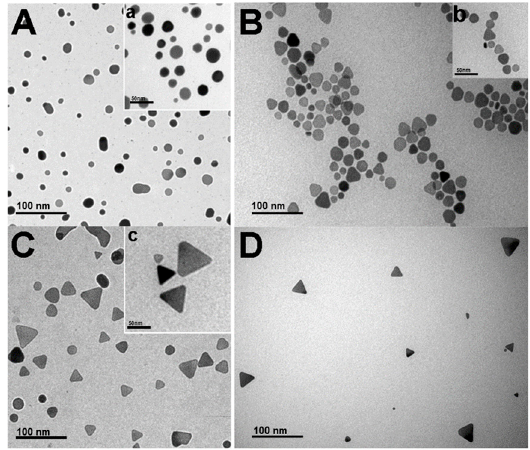
Figure 3. TEM and HR-TEM of Ag Nanoparticles ( A , a ), intermediate phase ( B , b ), Ag Nanoprisms ( C , c ), and ( D ) TEM of Ag-NPrs after washing (the inset a,b,c scale bar is 50 nm).